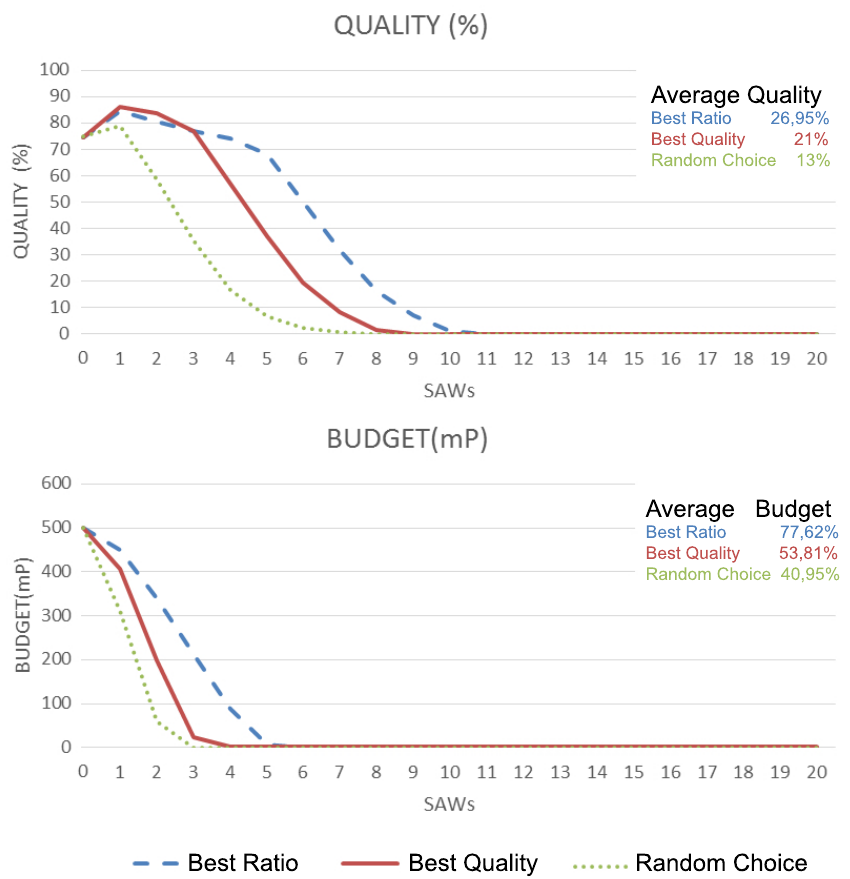
Figure 1. DPB results under low budget